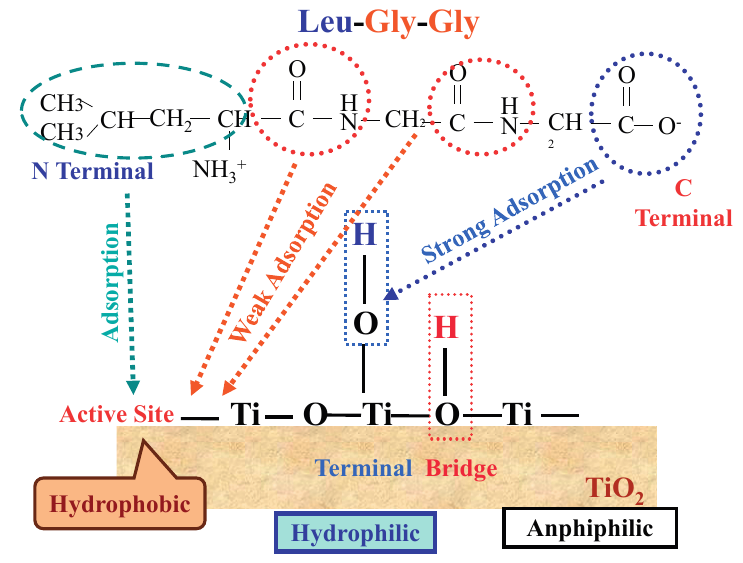
Figure 15. Schematic presentation of the plausible adsorption of the peptide (Leu-Gly-Gly) on the hydrophilic and hydrophobic surface of TiO 2 (ST-01). Reprinted with permission from [43] © 2014 American Chemical